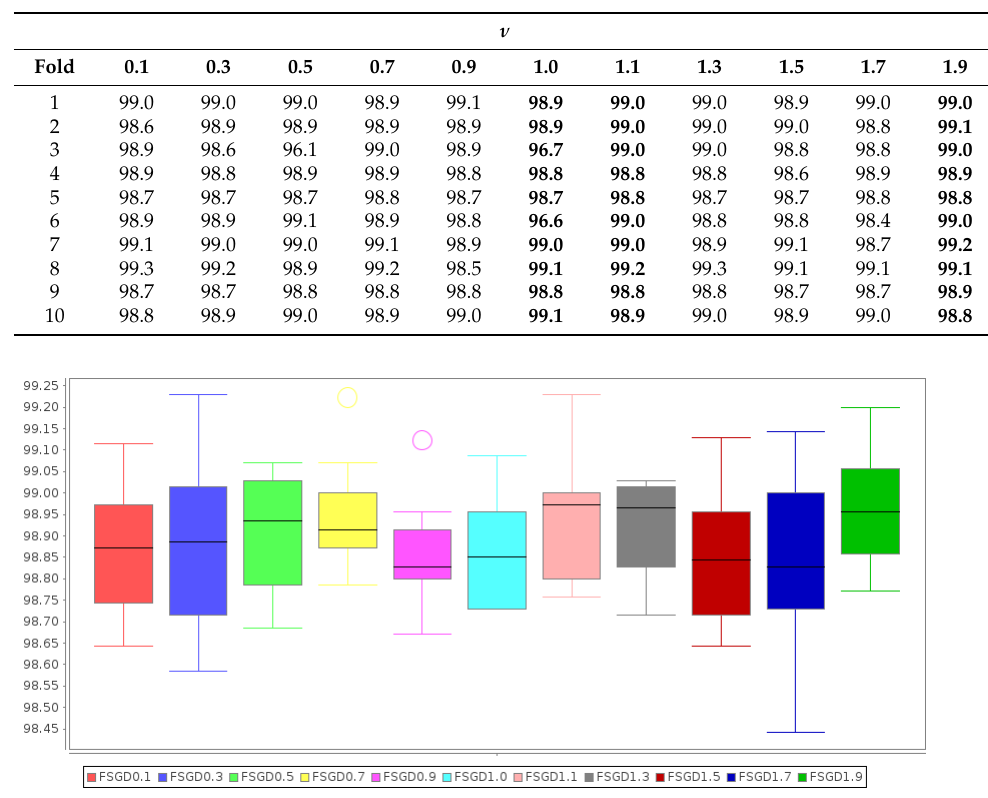
Figure 2. Experiment 1.2: Boxplots accuracies for FSGD with η = γ = 0.1, ν = 0.1,0.3,. . .,1.9 and 1.0. From Experiment 1.2, it is deduced that the use of momentum contributes to better performance close to 99%, while FSGD without momentum in Experiment 1.1 barely reaches about 95.6% for the last